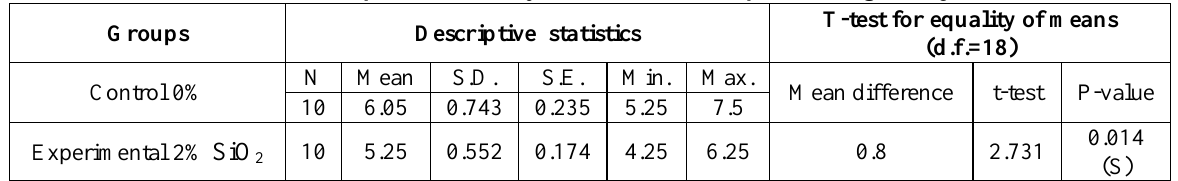
Table 2: Descriptive summary and T-test for impact strength (Kj/m 2 ) Descriptive statistics Groups